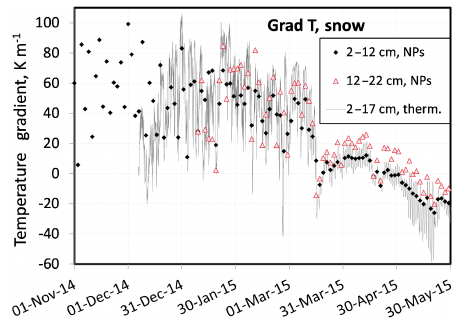
Figure 11. Time series of the temperature gradient in the snow. Val- ues were obtained from the heated needle probes at 2, 12 and 22cm, with a data point every 2 days. Thermistors at 2 and 17cm also measured temperature every hour, and the values are shown with an hourly resolution. The different start dates of each curve are deter- mined by the date where the snow height reached the relevant level.